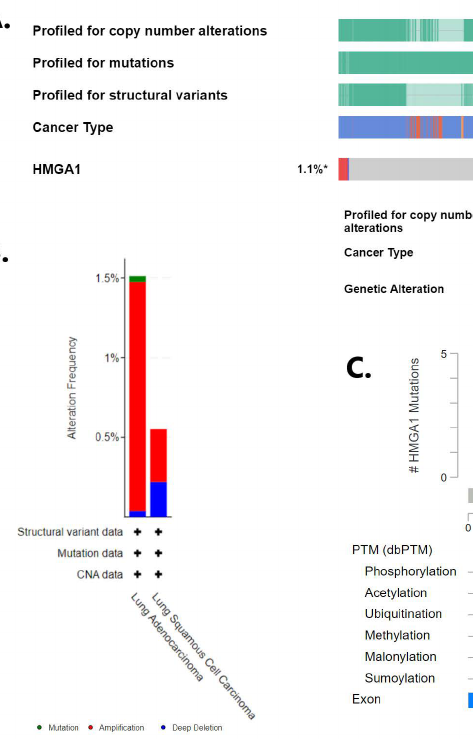
Figure 8. Genomic alterations of HMGA1 in lung cancer according cBioPortal. ( A ) Oncoprint of the HMAG1 in lung cancer, ( B ) Incidence of different alterations according to NSCLC types, ( C ) Details of HMGA1 missense mutation found in lung